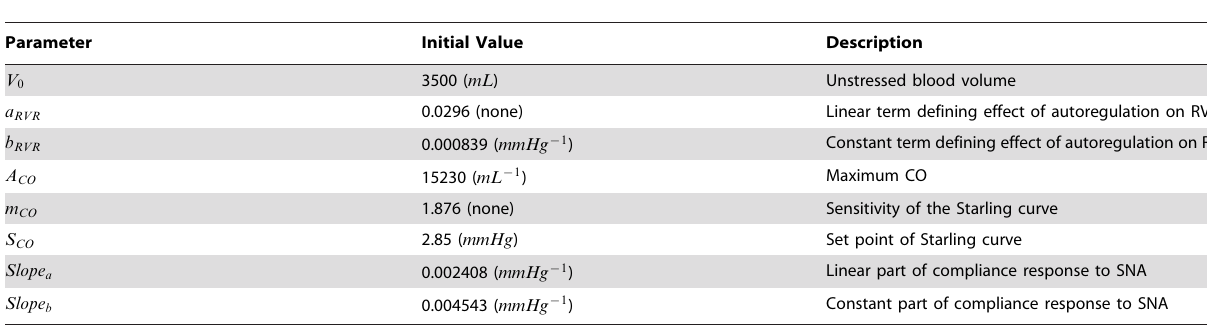
Table 4. Parameters of cardiovascular integration in the